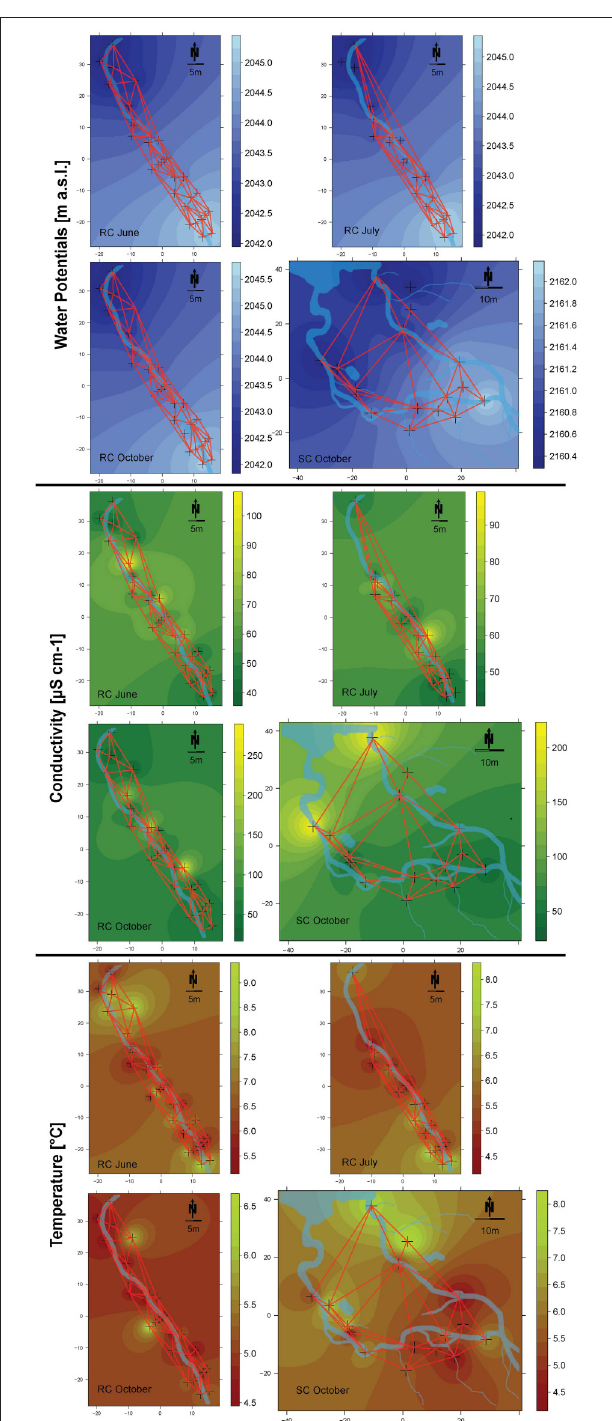
FIGURE 2 | Spatial maps of inverse distant weighting (IDW) inter- and extrapolations of water potentials (blue), conductivity (green), and temperature (red). Sampled locations are depicted as crosses on the maps. Refer to the respective color keys for inter- and extrapolated values of water potentials (depicted as m a.s.l.), conductivity (depicted as µ S cm − 1 ) and temperature (depicted as ◦ C). The connectivity grid used for the different models and the streams are depicted on the